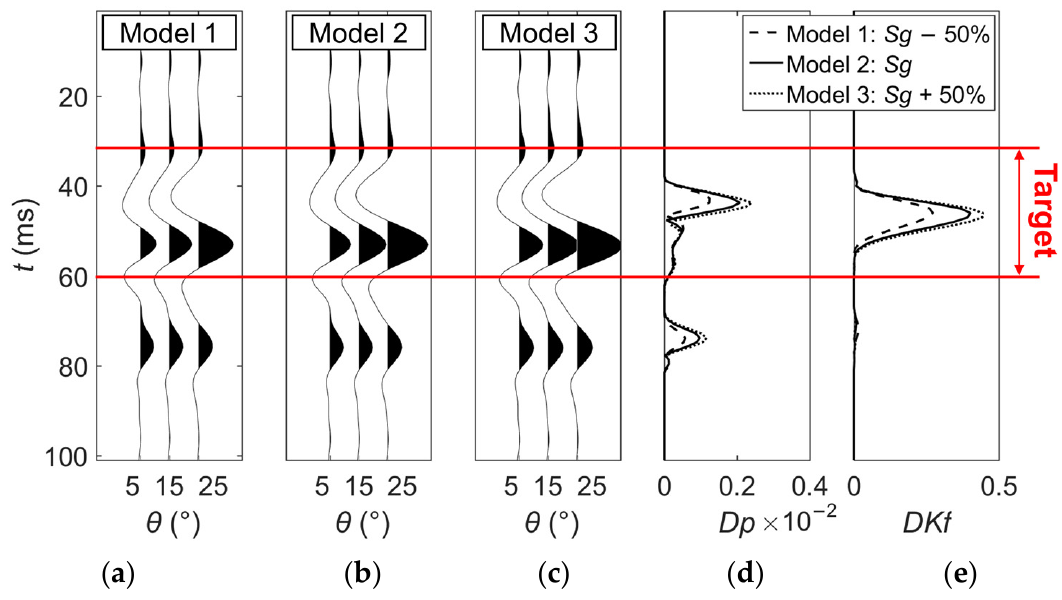
Figure 8. ( a – c ) Synthetic data and inverted results of ( d ) D P and ( e ) D Kf for the three S g models in